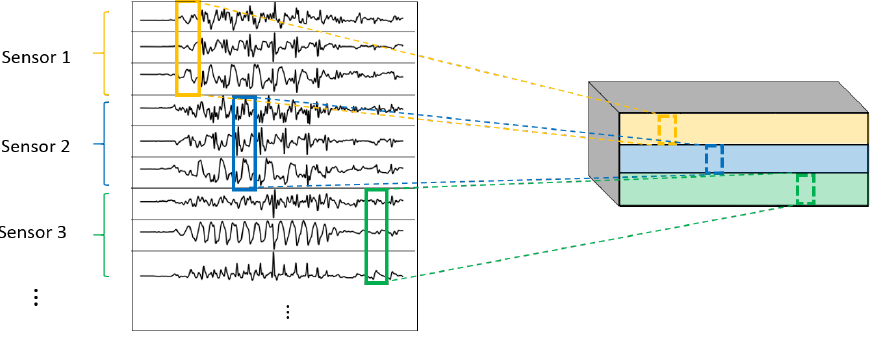
Figure 10. 2DCNN per sensor logic.